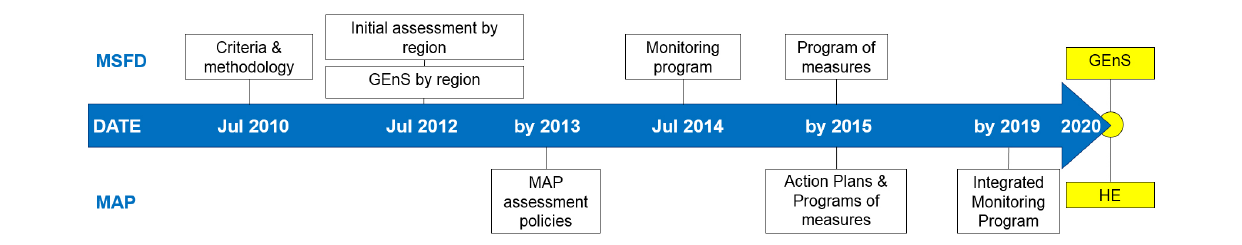
Fig. 1 . Synthetic comparison of Marine Strategy Framework Directive (MSFD) and Ecosystem Approach Strategy (ECAP) milestones (UNEP-MAP 2012; modified from O’Higgins and Roth 2010)